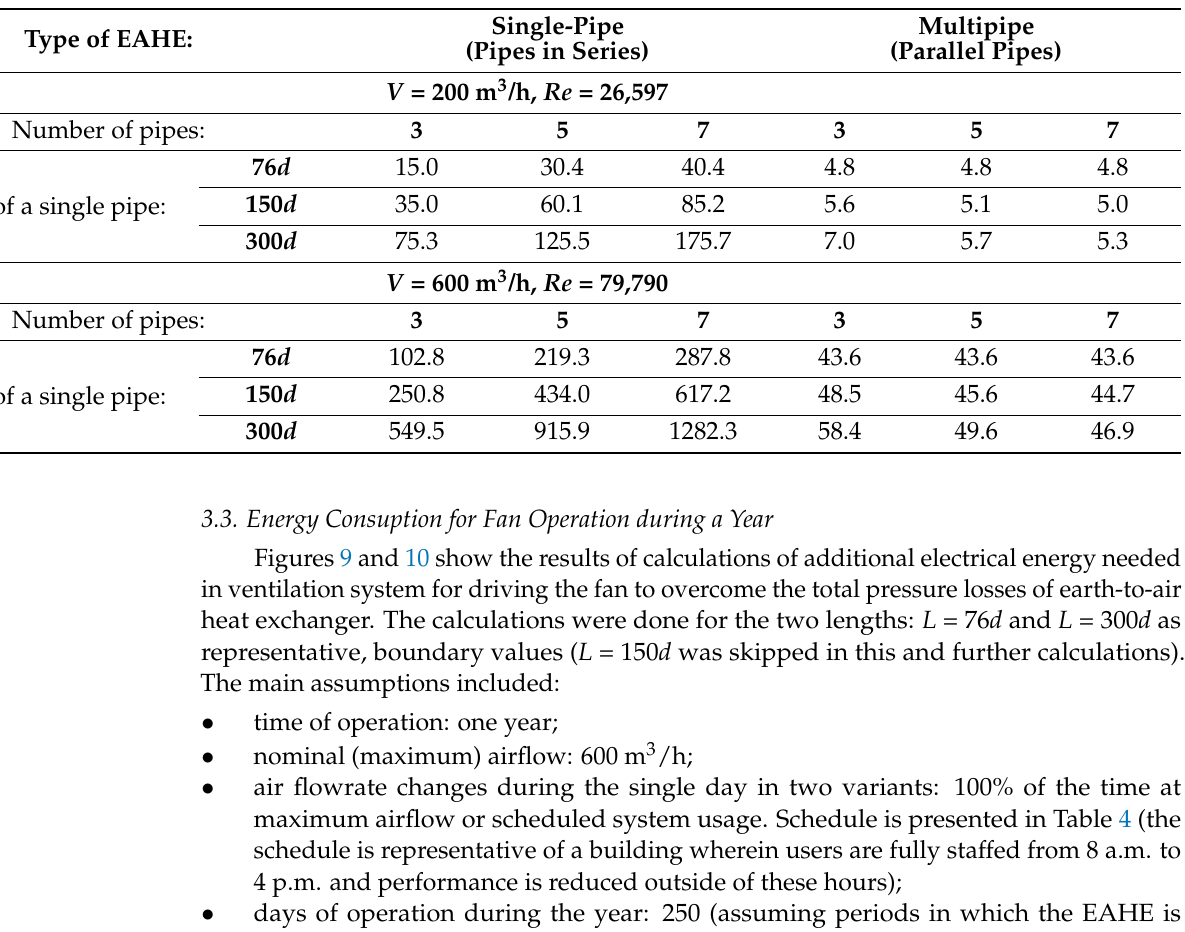
Multipipe (Parallel Pipes)